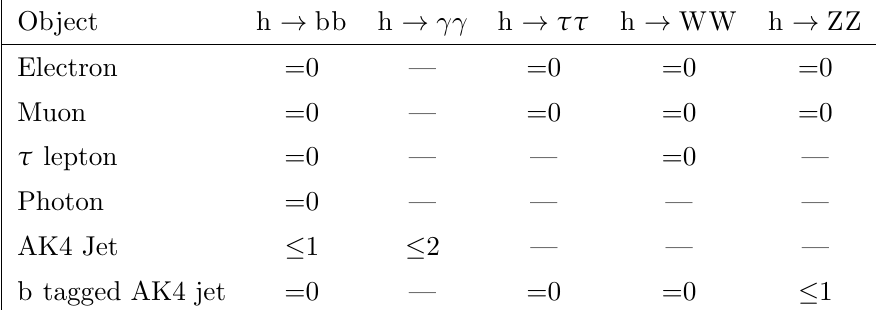
Table 2 . Summary of the maximum number of additional objects allowed in an event for each anal- ysis. A dash means that no restriction on the corresponding object is applied in the corresponding